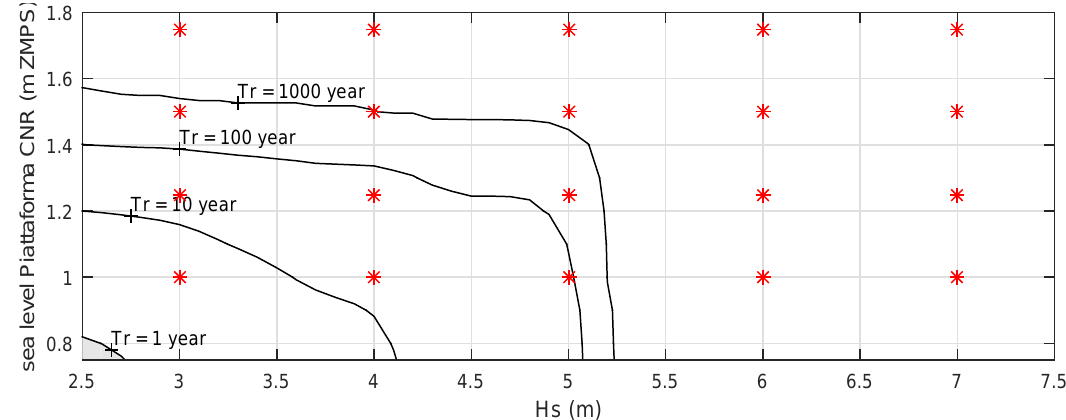
Figure 8. Red dots are the couple Hs – ζ chosen as input for the models (ZMPS is a reference level for